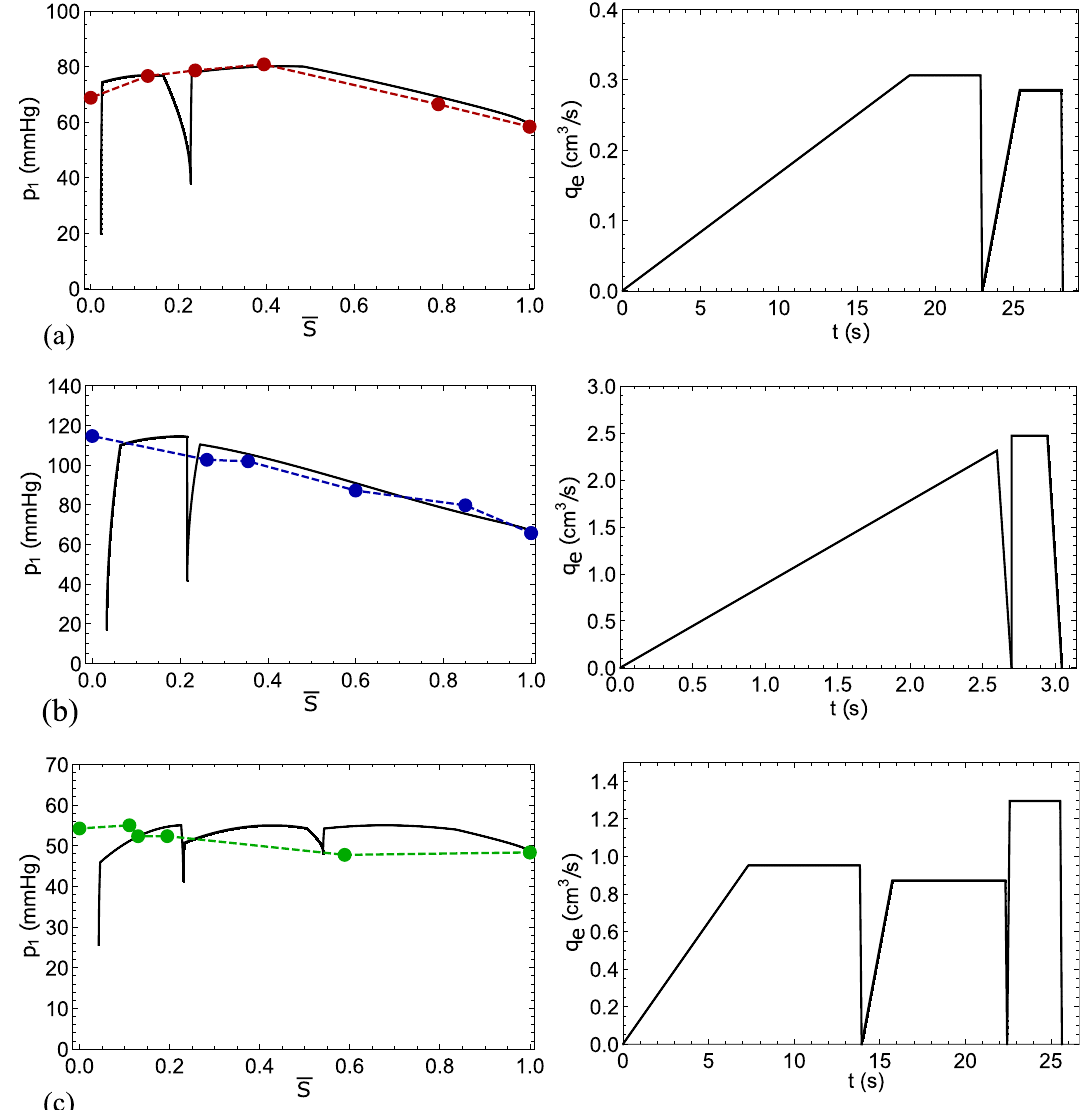
Figure 3. Comparison of the AVM inlet pressures p 1 obtained during neurosurgical surgery (circles) and as a result of numerical simulation (solid line), as well as the corresponding optimal embolization regimes q e ( t ) : ( a ) for patient K , ( b ) for patient S , ( c ) for patient P